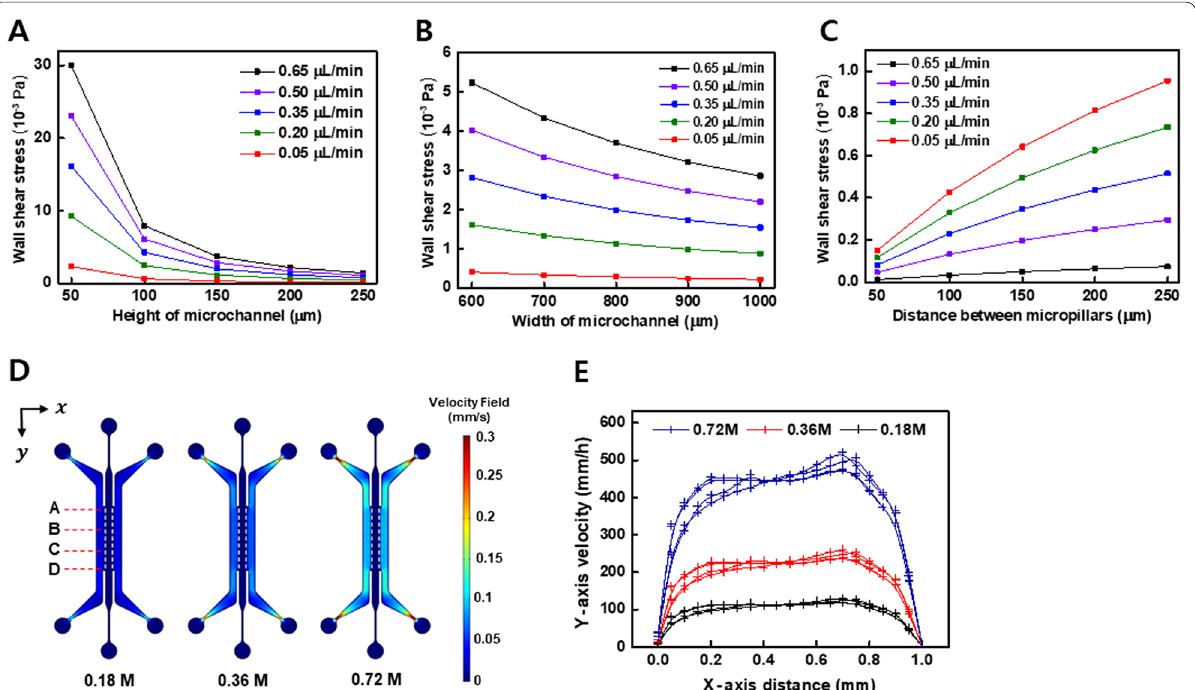
Fig. 2 Simulation of a gut‑on‑a‑chip under various fluidic flows and geometric conditions. A Wall shear stress is calculated with respect to the height of the microchannel. B Wall shear stress is calculated with respect to the width of the microchannel. C Wall shear stress is calculated with respect to the distance between the micropillars. D Flow speed distribution in the cell culture microchannel. CFD simulations were performed to analyze the velocity at various concentrations of 0.18 M, 0.36 M, 0.72 M PEG solutions. E Velocity distribution inside the microchannel is calculated